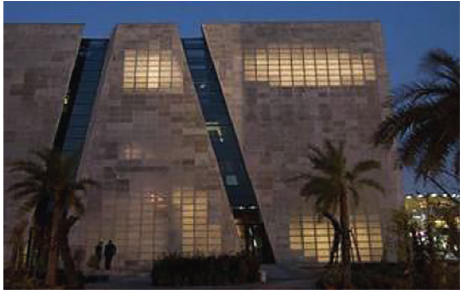
Figure 1: Translucent concrete of Italian pavilion.